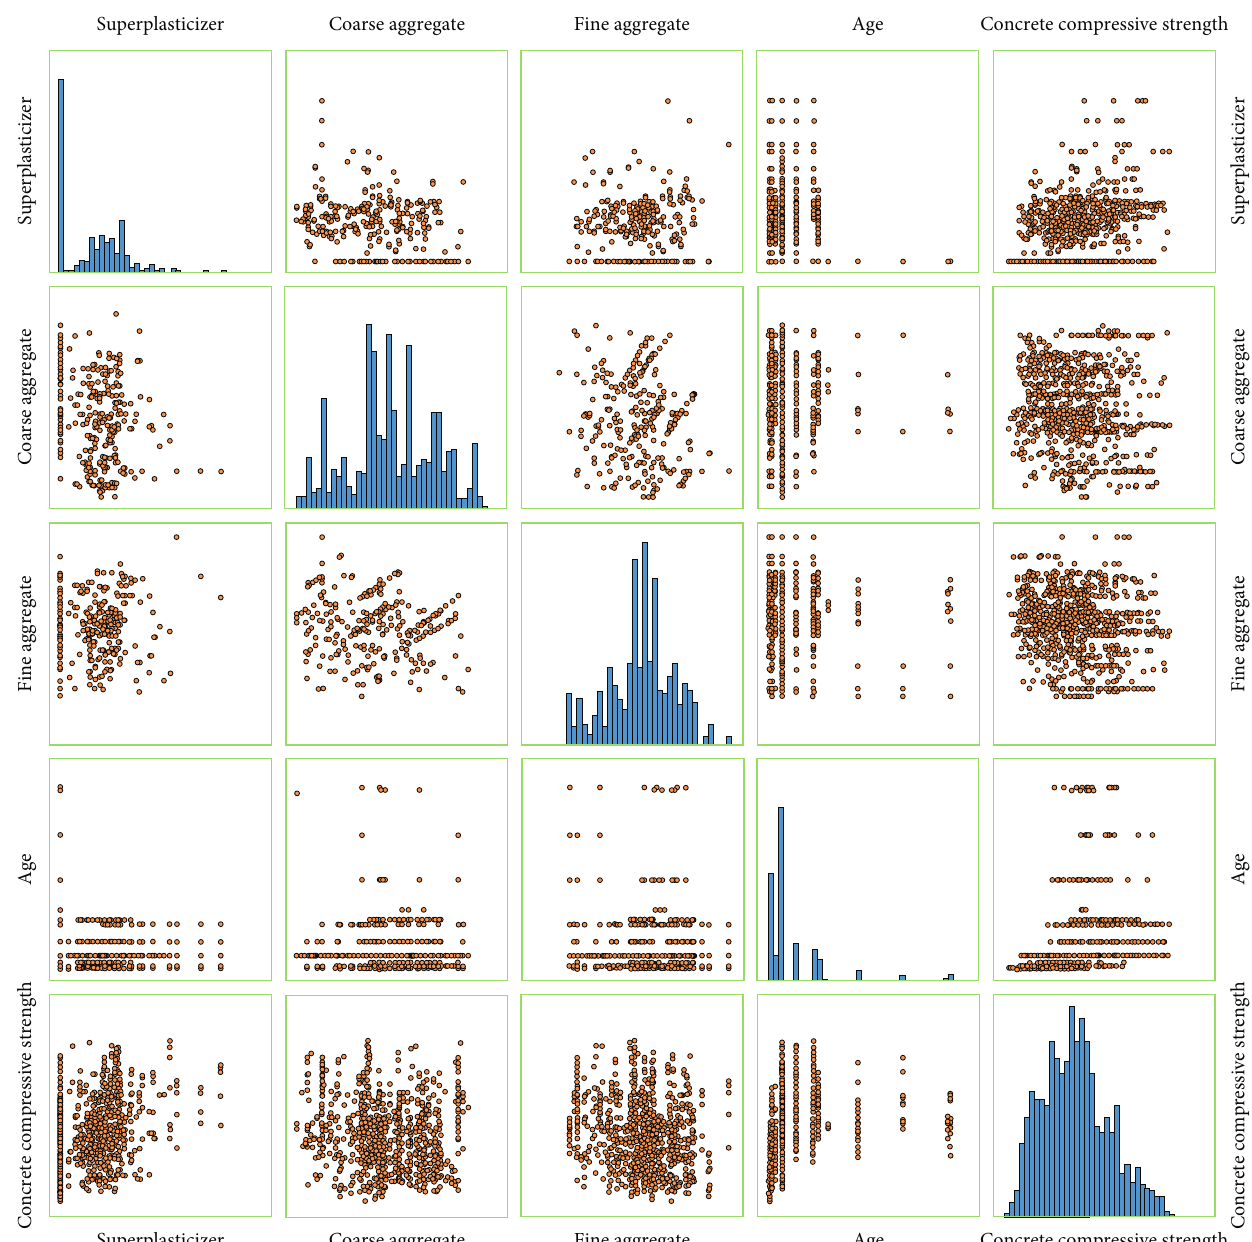
Figure 10: Plot of the relationship between output variables and the last 4 input feature variables (superplasticizer, coarse aggregate, fi ne aggregate, and